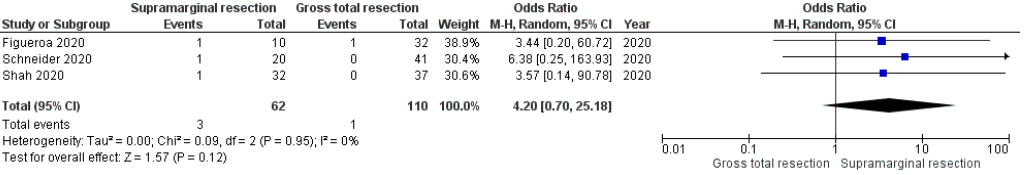
Figure 4. Forest plot displaying odds ratio and 95% CI estimates for postoperative meningitis in studies [29,33,34] evaluating SMR compared to GTR in GB patients. X-axis locations of squares represent the odds ratio; the bigger the square, the greater the weight due to sample size. The diamond corresponds to the odds ratio of the overall data.